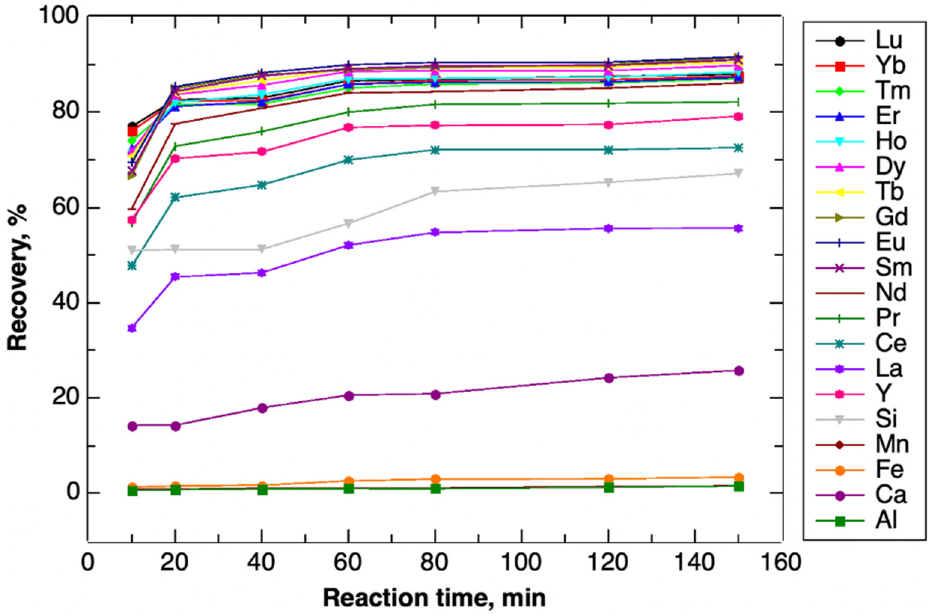
Figure 6. Effect of reaction time on elemental recovery of rare earth elements and contaminants (Al, Ca, Fe, Mn, Si) at a fixed pH of 1.5 and dosage of 15 g/L.